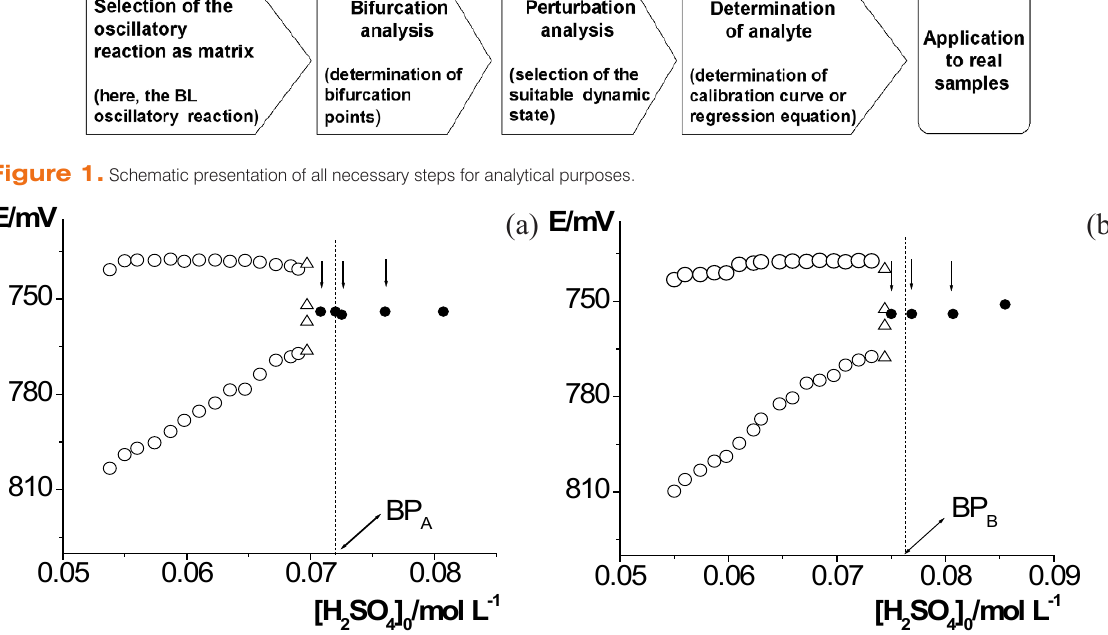
Figure 2. Bifurcation diagram obtained at temperature 55.0°C (a) and 58.0°C (b), showing a transition with increasing acidity from large-amplitude oscillations (open circles) to stable stationary state (solid circles) via aperiodic (chaotic) mixed mode large and small amplitude (open triangle) oscillations. Open circles and triangle denote minimal and maximal potential in an oscillation. The extrapolated values of the bifurcation between stable and unstable steady stationary state occurs for acidity BP